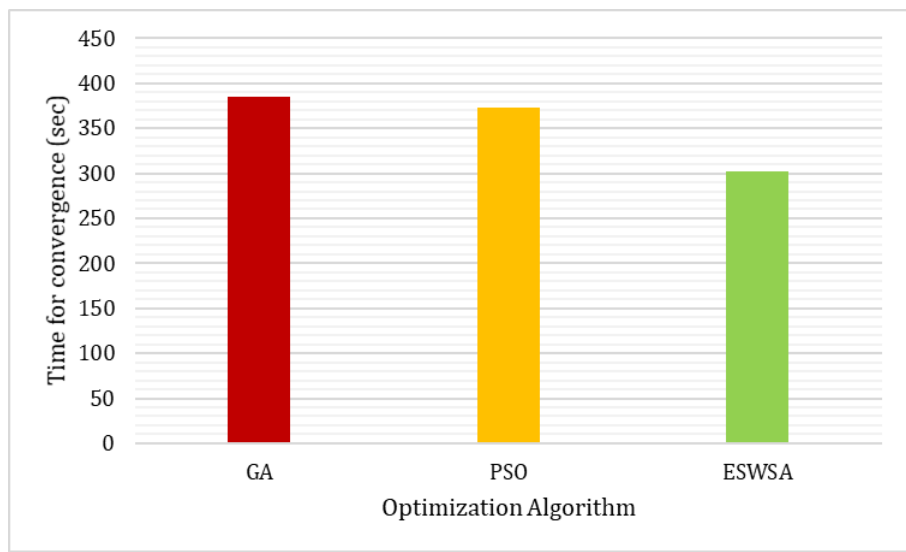
Figure 6. Time of